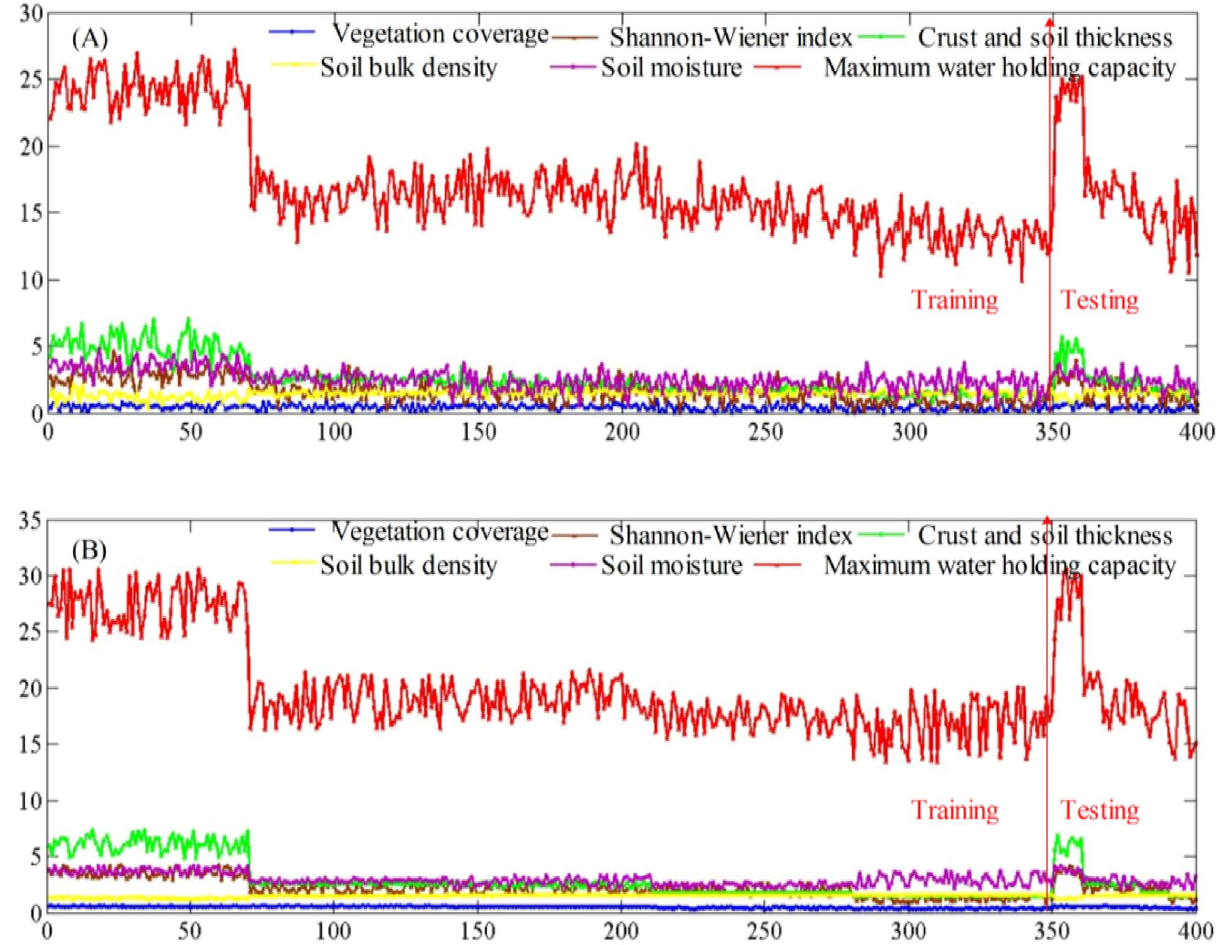
Figure 3. The Monte Carlo simulation results of evaluation indexes. ( A ) The evaluation indexes are uniformly distributed; ( B ) The evaluation indexes are normally distributed.